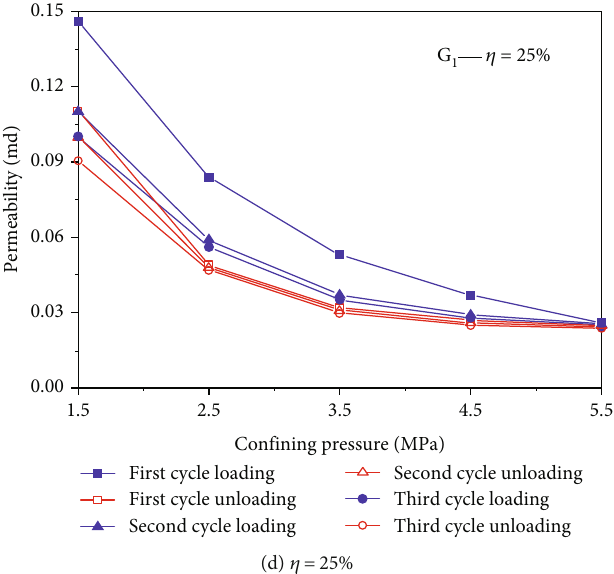
Figure 6: Relationship between permeability and con fi ning